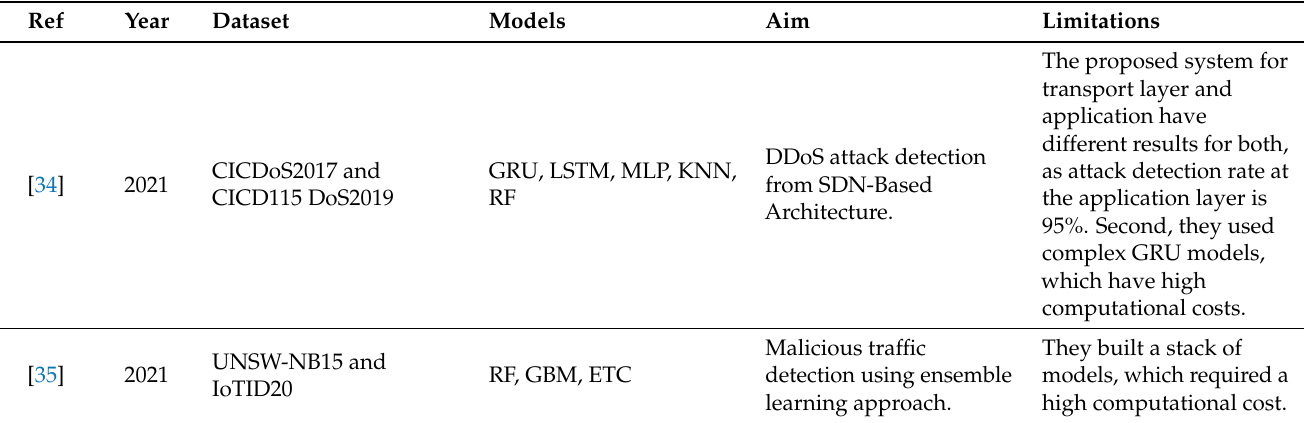
Table 1. Summary of related